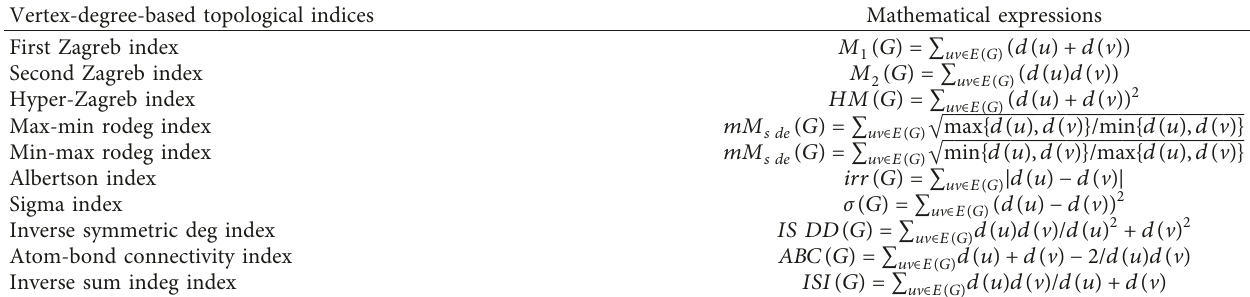
Figure 2: The chemical structures of favipiravir, ritonavir, and their analogs [29]. Table 1: Topological indices and their mathematical